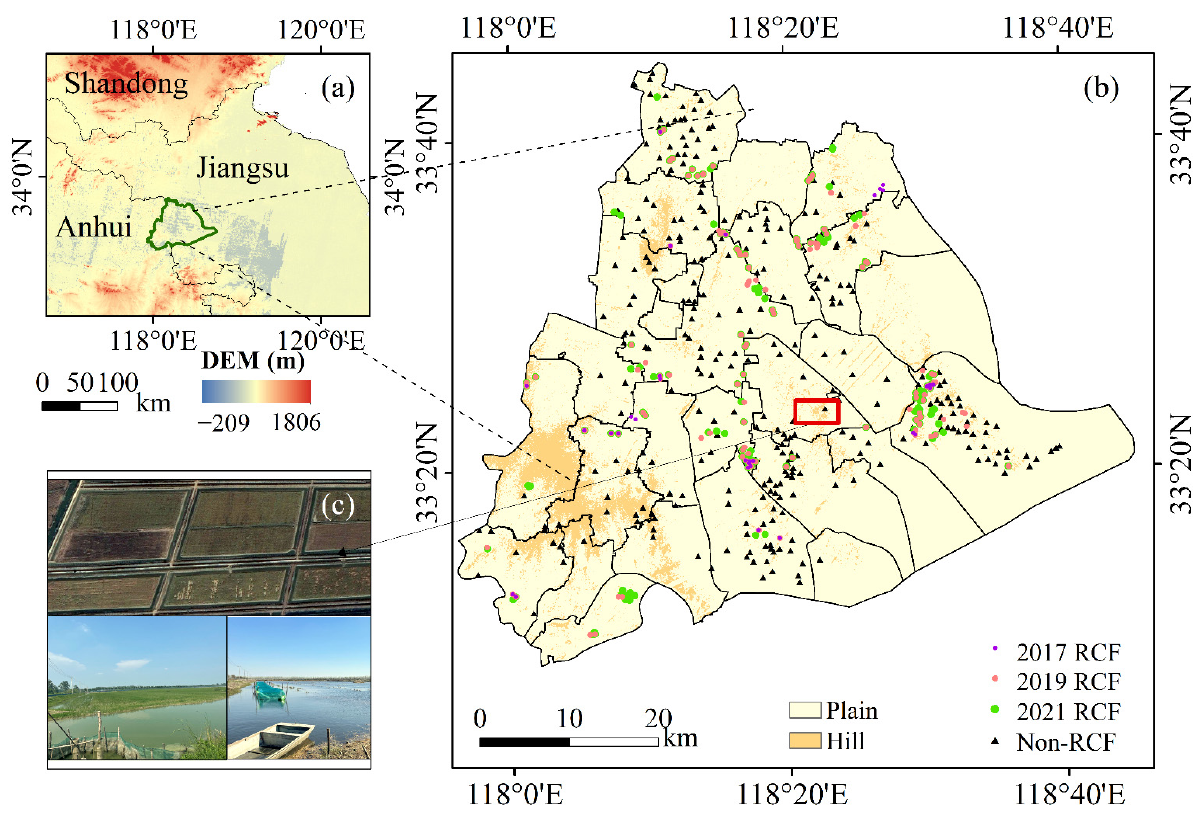
Figure 1. Study area and validation samples. ( a ) Location of Sihong Country in China; ( b ) adminis- trative boundaries and validation samples of Sihong; ( c ) RCFs in two periods.